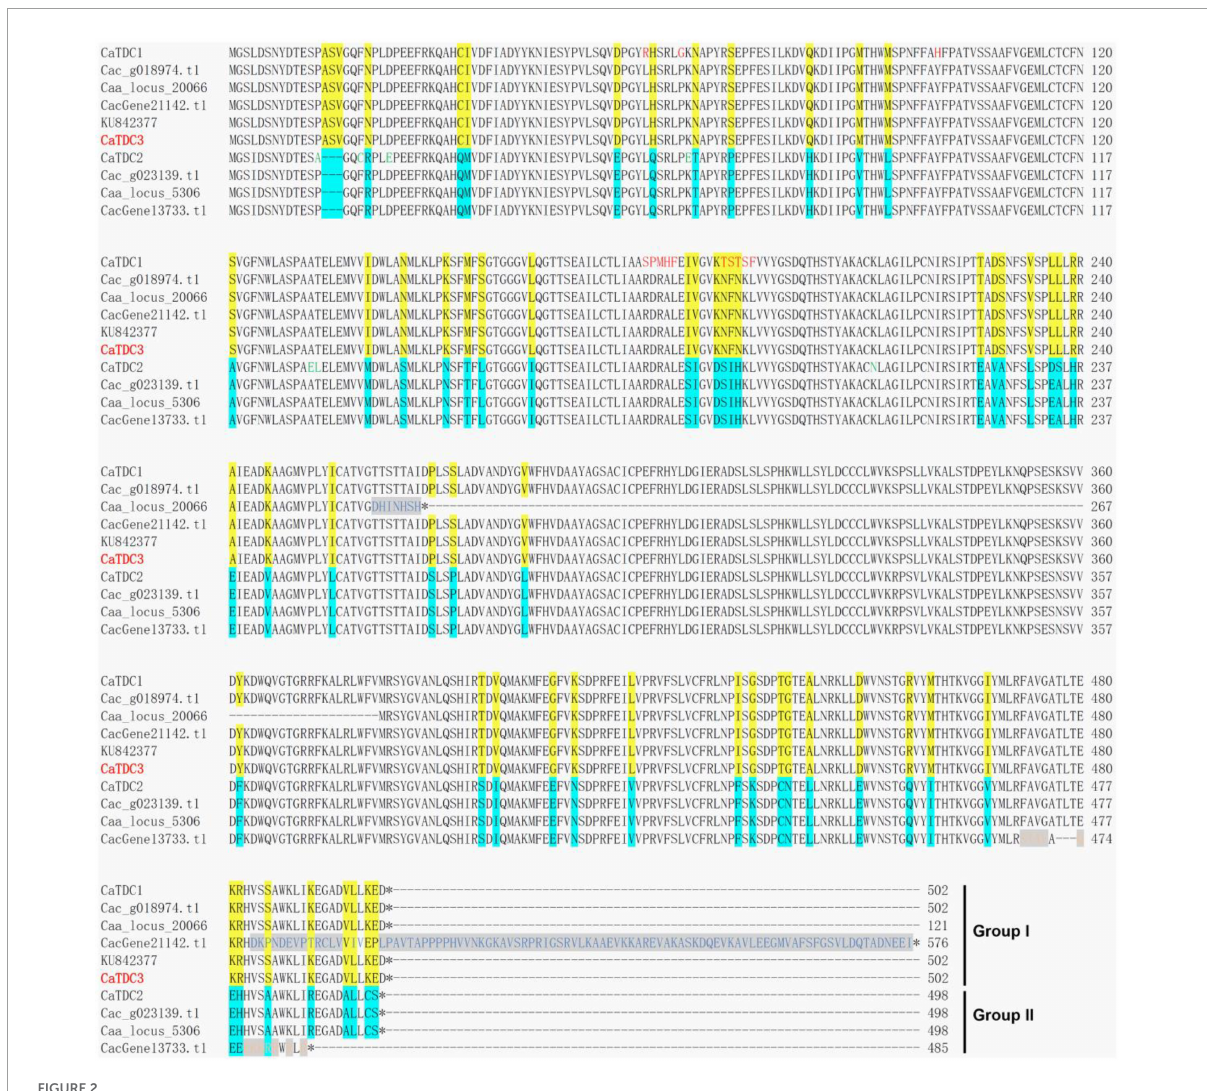
FIGURE2 Multiple amino acid residue sequences alignment of the functionally characterized CaTDC1 and CaTDC2 and the annotated TDCs from Camptotheca acuminata . The amino acid residue sequences of CaTDC1 (López-Meyer and Nessler, 1997), CaTDC2 (López-Meyer and Nessler, 1997), and KU842377 (Sadre et al., 2016) were retrieved from NCBI database. Caa_locus_20066 and Caa_locus_5306 were retrieved from C. acuminata transcriptome dataset downloaded from http://medicinalplantgenomics.msu.edu by Góngora-Castillo et al. (2012). Cac_g018974.t1 and Cac_g023139.t1 were retrieved from C. acuminata genome dataset downloaded from http://medicinalplantgenomics.msu.edu by Zhao et al. (2017). CacGene21142.t1 and CacGene13733.t1 were retrieved from C.